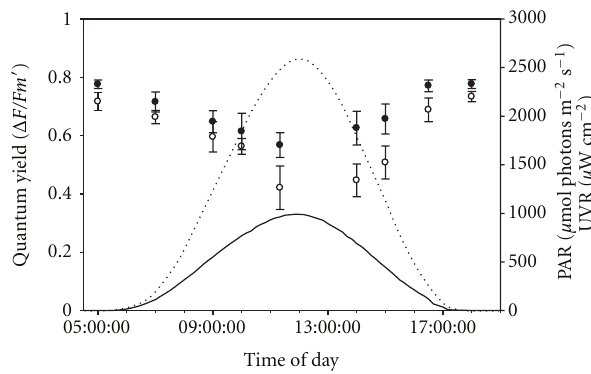
Figure 6: Daily changes in e ff ective quantum yield ( Δ F/Fm (cid:3) ) of plants grown on the water table for 14 days under control filters (open circles) or UV filters (closed circles) and PAR (400–700 nm) measured above the plants on the water table (full line) and UVR (300–400 nm) under the control filter (dotted line; there was no measurable UVR under the UV filter). Data points are means of 8 replicates ±